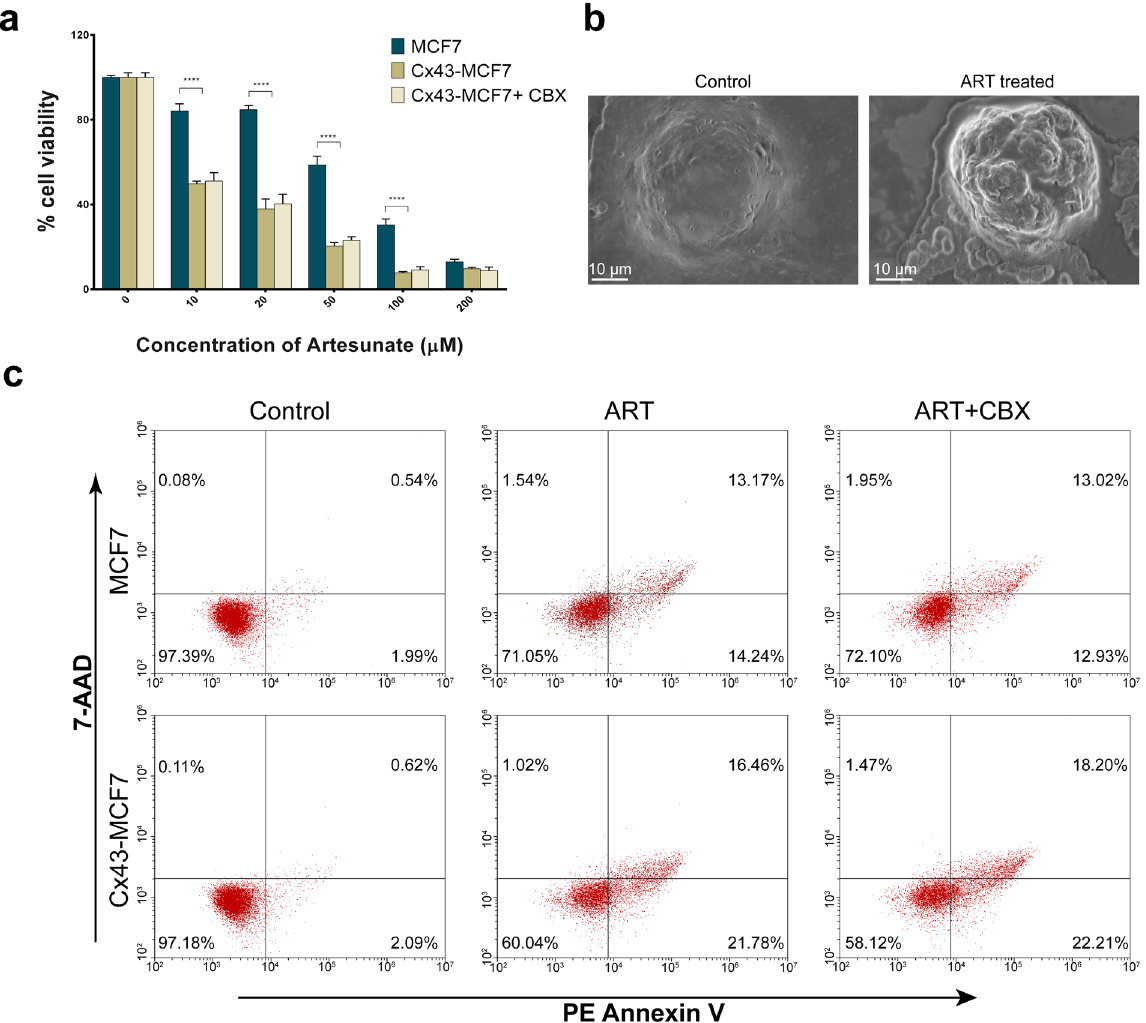
Figure 2. Cx43 overexpression in MCF7 cells enhanced the ART mediated cytotoxicity in dose dependent manner. ( a ) Both MCF7 and Cx43-MCF7 cells were subjected to treatment with increasing dose of ART or ART with 100 µ M of CBX for 48 h. At the end of treatment duration, cell viability was assessed by MTT assay. ( b ) Represents the FESEM image of control and ART treated cell. Onset of apoptosis in the form of membrane blebbing was prominent on ART treated MCF7 cell. ( c ) Flow cytometry analysis of the cytotoxic effect of ART on MCF7 and Cx43-MCF7 cells determined by PE Annexin V and 7-AAD